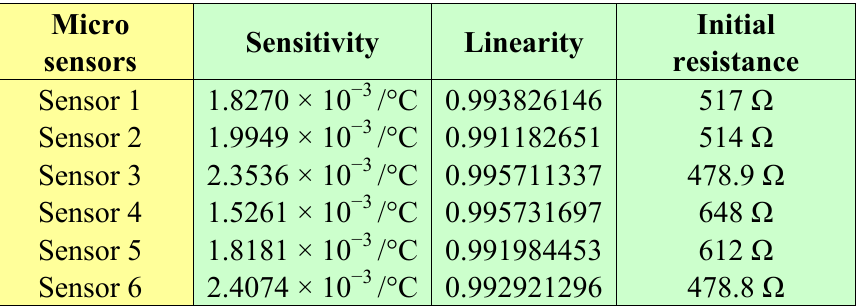
Table 4. Sensitivity of the micro temperature